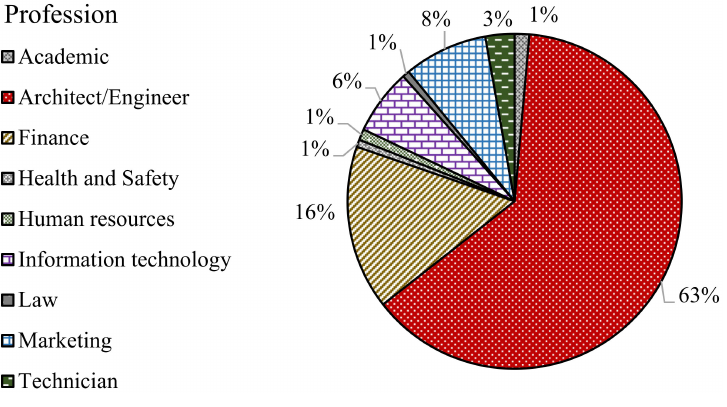
Figure 3. Distribution of respondents’ professions. Table 2. Profile of the